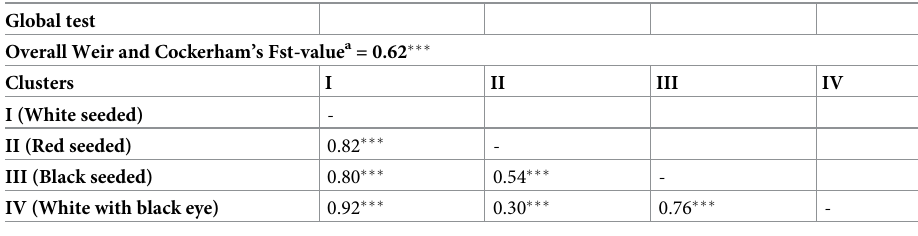
Table 6. Results of pairwise Fst analysis among clusters of Kersting’s groundnut accessions. Global test Overall Weir and Cockerham’s Fst-value a = 0.62 ���